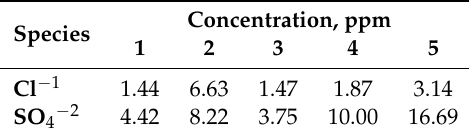
Table 4. Concentrations of sulfate (SO 4 − 2 ) and chloride (Cl − 1 ) extracted from five solid samples using the colorimetric method.